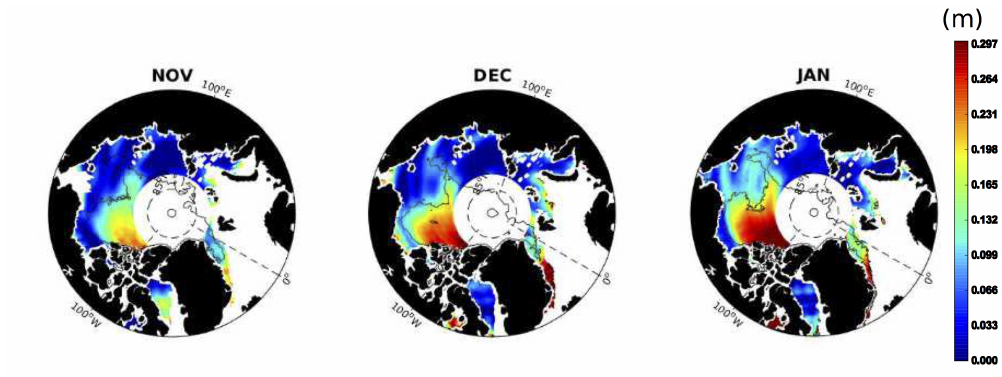
Figure 25. Maps of snow depth estimated from the combinaition of SARAL/AltiKa and CryoSat-2/SIRAL for November 2013, December 2013 and January 2014